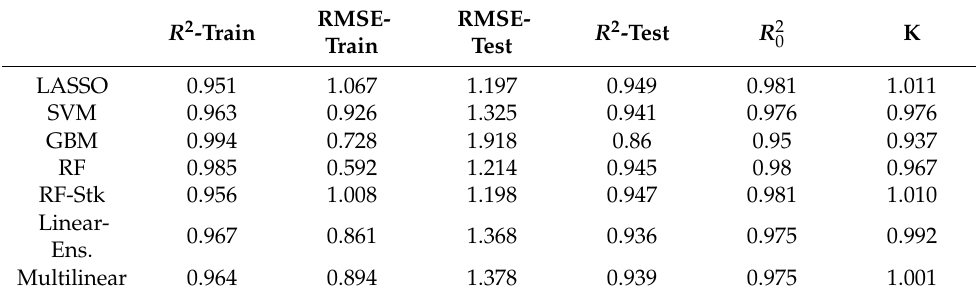
Table 2. The observed statistical parameters for each generated model in the prediction of the affinity constant logarithms (LogK) of Eu 3+ complexation. See Supplementary files for further details. RMSE- RMSE- R 2 -Train R 2 -Test Train Test LASSO